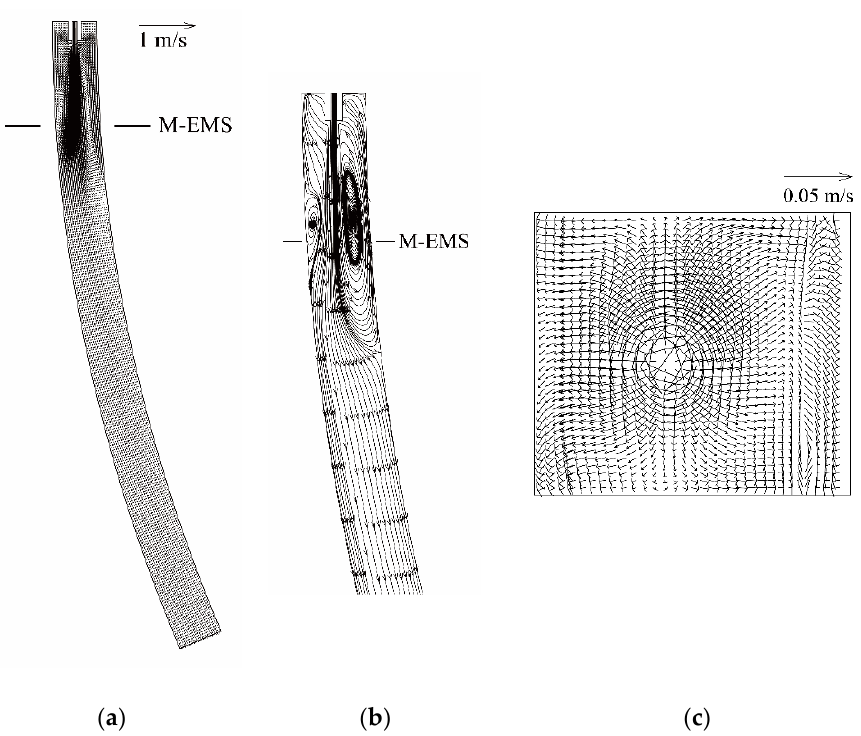
Figure 6. Liquid steel flow in curved bloom continuous caster without M-EMS: ( a ) vertical longitudinal-section; ( b ) stream line (enlarged part); ( c ) M-EMS central cross-section.